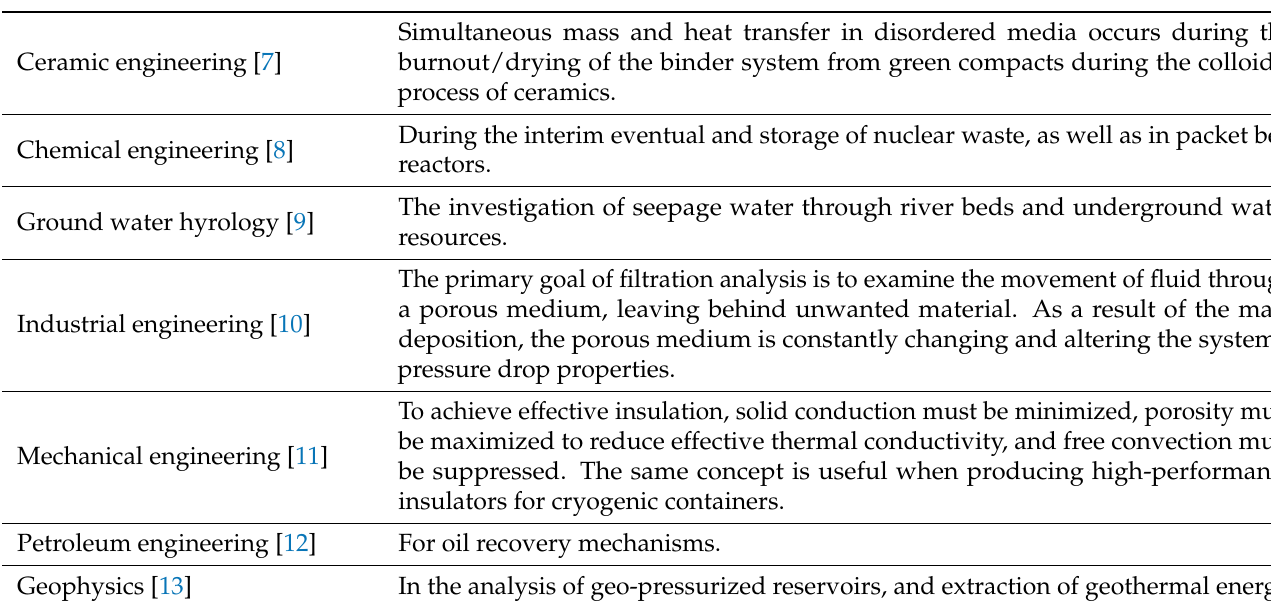
Table 1. Applications of heat transfer through porous